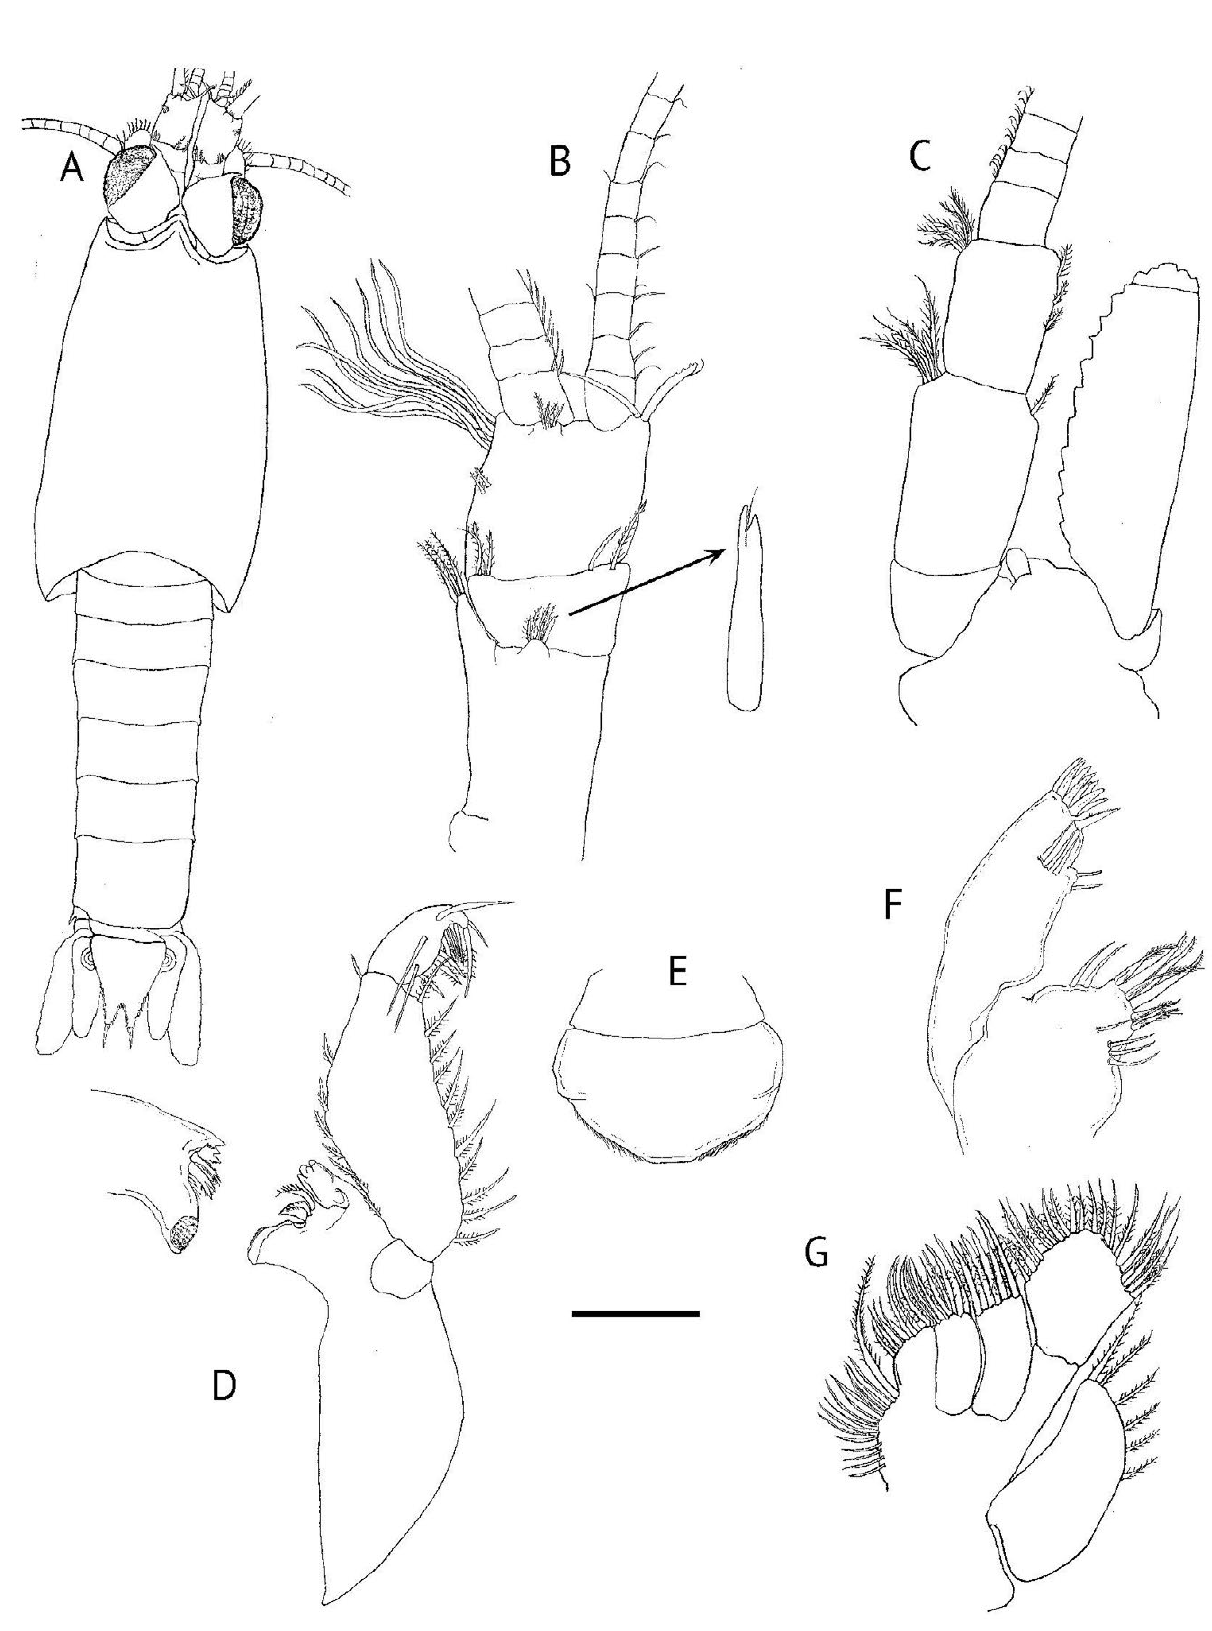
Figure 2. Heteromysis ( Olivemysis ) cocoensis n. sp. adult male, 3.0. mm. A. Dorsal view. B. Antennular peduncle with enlargement of modified flagellate seta. C. Antennal peduncle and scale. D. Mandibles with right palp. E. Labrum. F. Maxillule. G. Maxilla. Scale: A, 0.4 mm; B–G, 0.1